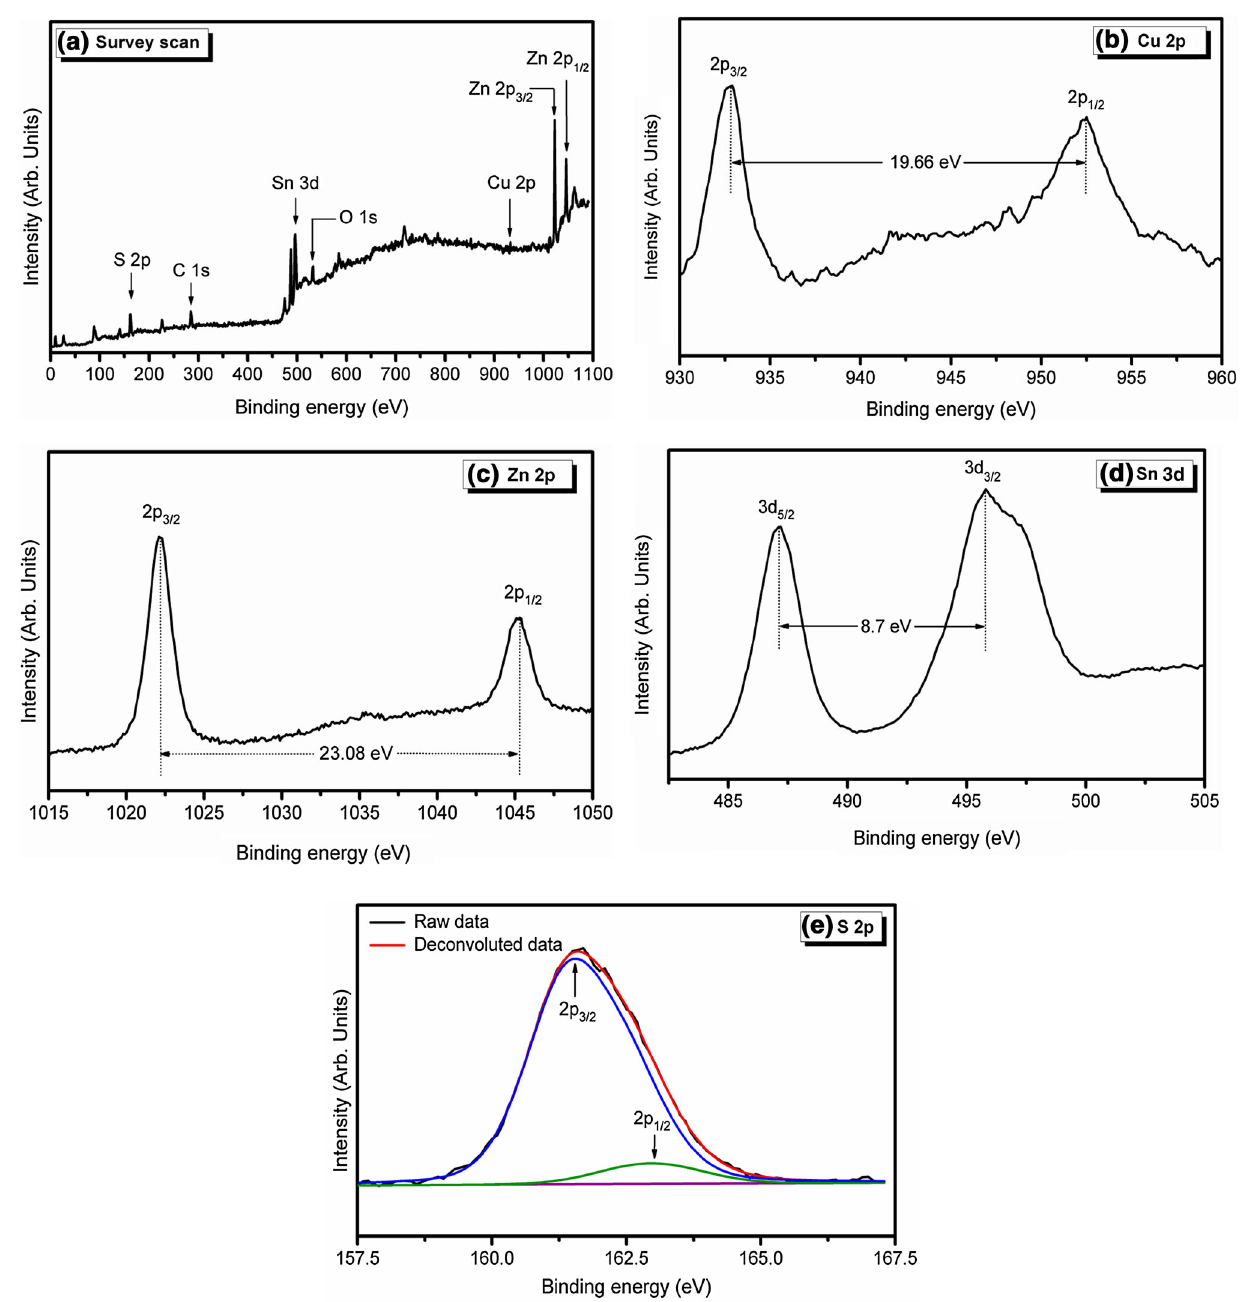
Fig. 3 Typical XPS spectra for CZTS film after calcination at 400 (cid:3) C. a Survey scan in the range 0–1100 eV. b High-resolution XPS spectrum of Cu 2 p in the range 930–960 eV. c Zn 2 p spectra